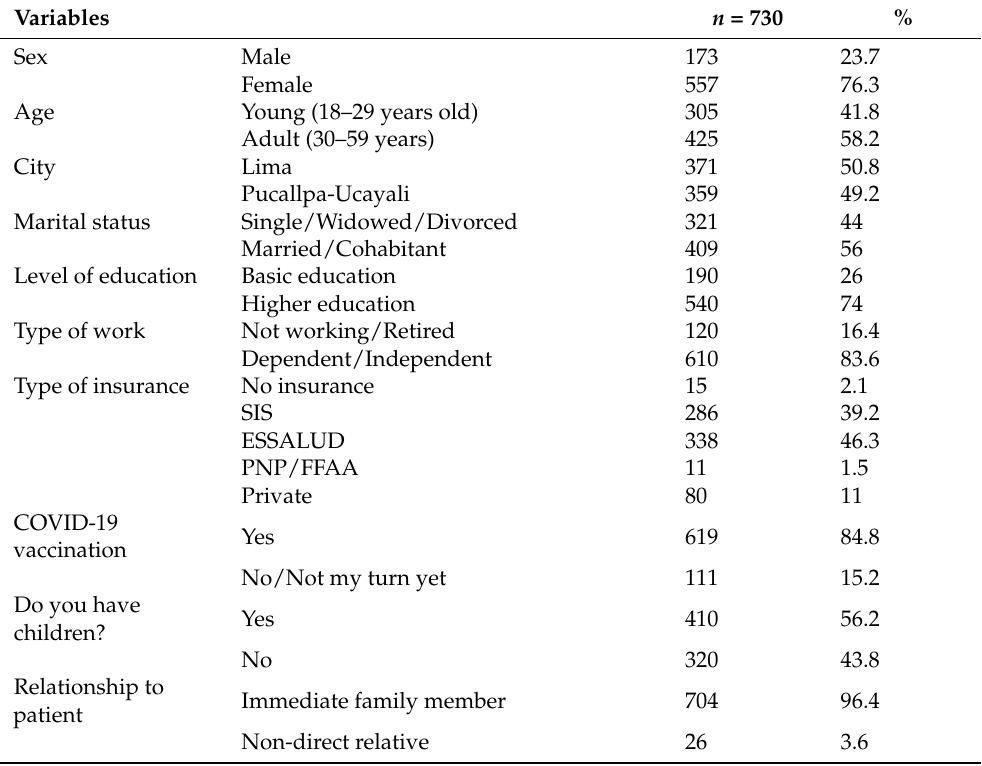
Table 1. General characteristics of caregivers of post-COVID-19 patients.